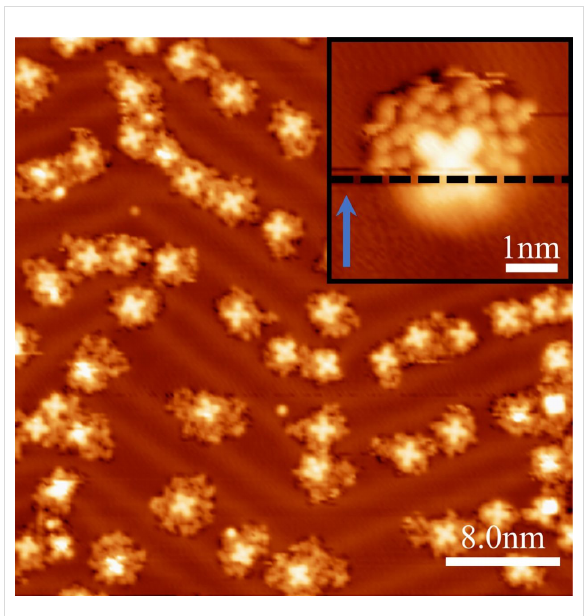
Figure 4: Constant-current STM images of the co-adsorption of FePc and N 2 O molecules on a Au(111) surface (200 mV, 20 pA, 40 × 40 nm 2 ), imaged with a N 2 O-functionalized tip. Inset: STM image (50 mV, 20 pA, 5 × 5 nm 2 ) of a FePc molecule surrounded by N 2 O species, demonstrating a tip-functionalization event (on the scan line marked by the dashed line). The scan direction is indicated by a blue